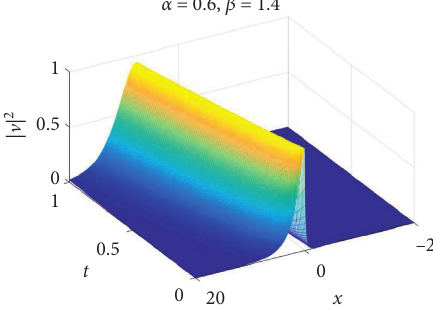
Figure 2: The trace of the solution to | v | 2 of FCNLSE (32) with α � 0 . 6 and β � 1 . 4.